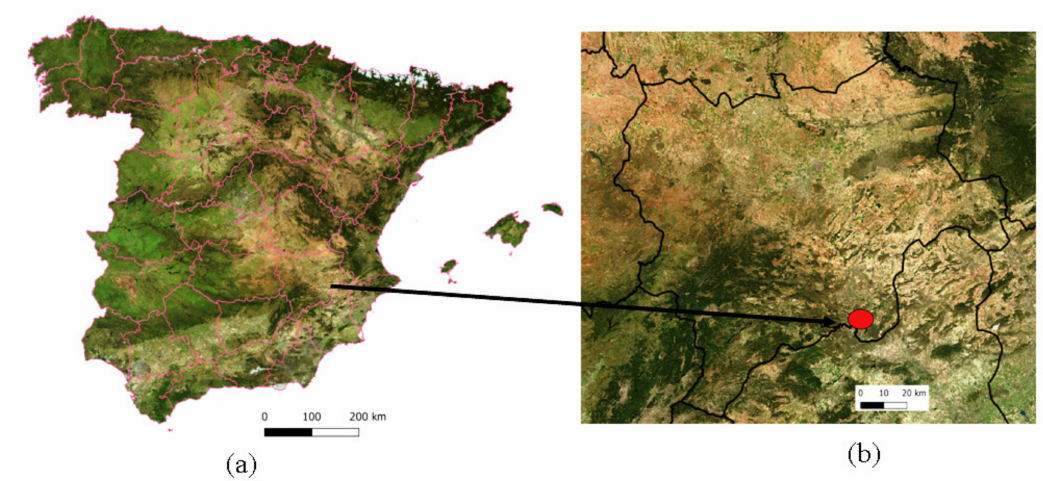
Figure 1. The provinces of Spain ( a ) and the experimental area of Sierra de Los Donceles in the Province of Albacete (( b ), in